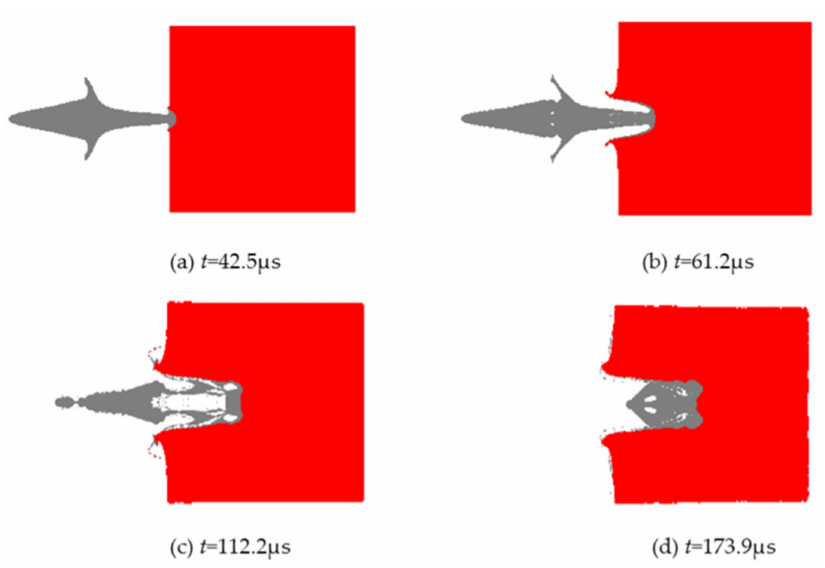
Figure 7. Numerical simulation results of the damage effect of the reactive jet on the steel target.